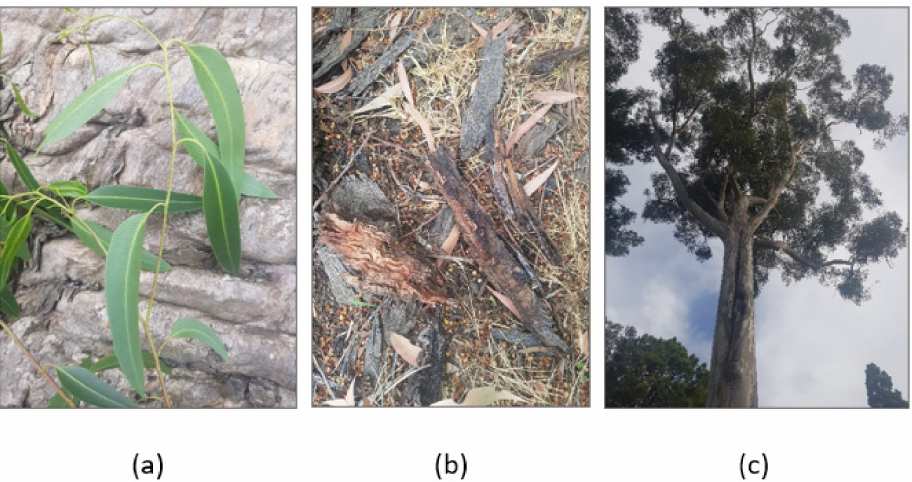
Figure 4. Photos of ( a ) Eucalyptus cladocalyx (leaf), ( b ) Eucalyptus pilularis (bark), ( c ) Eucalyptus cladocalyx (whole tree). Photos are taken from the “Royal Botanic Gardens Victoria—Melbourne